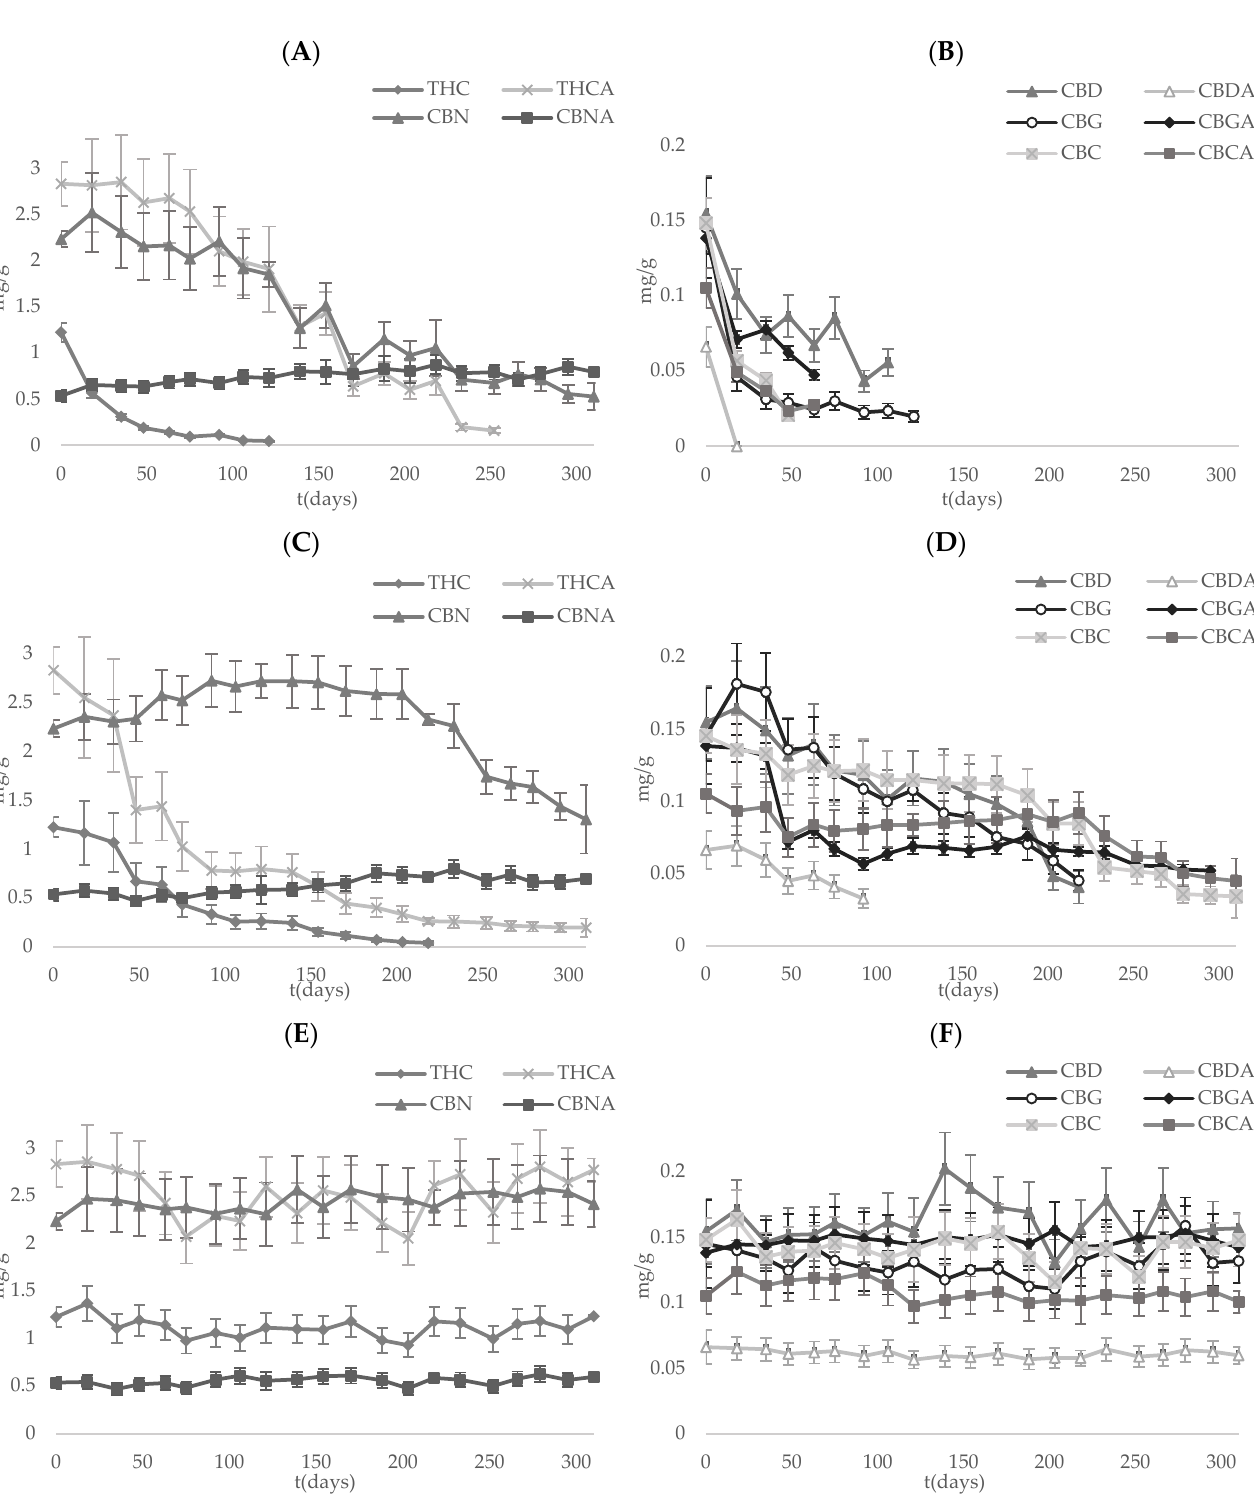
Figure 3. Evolution of cannabinoid content in different storage conditions: ( A , B ) at RT with natural day–night cycle light exposure; ( C , D ) at RT without light exposure; ( E , F ) at 4 °C without light exposure.